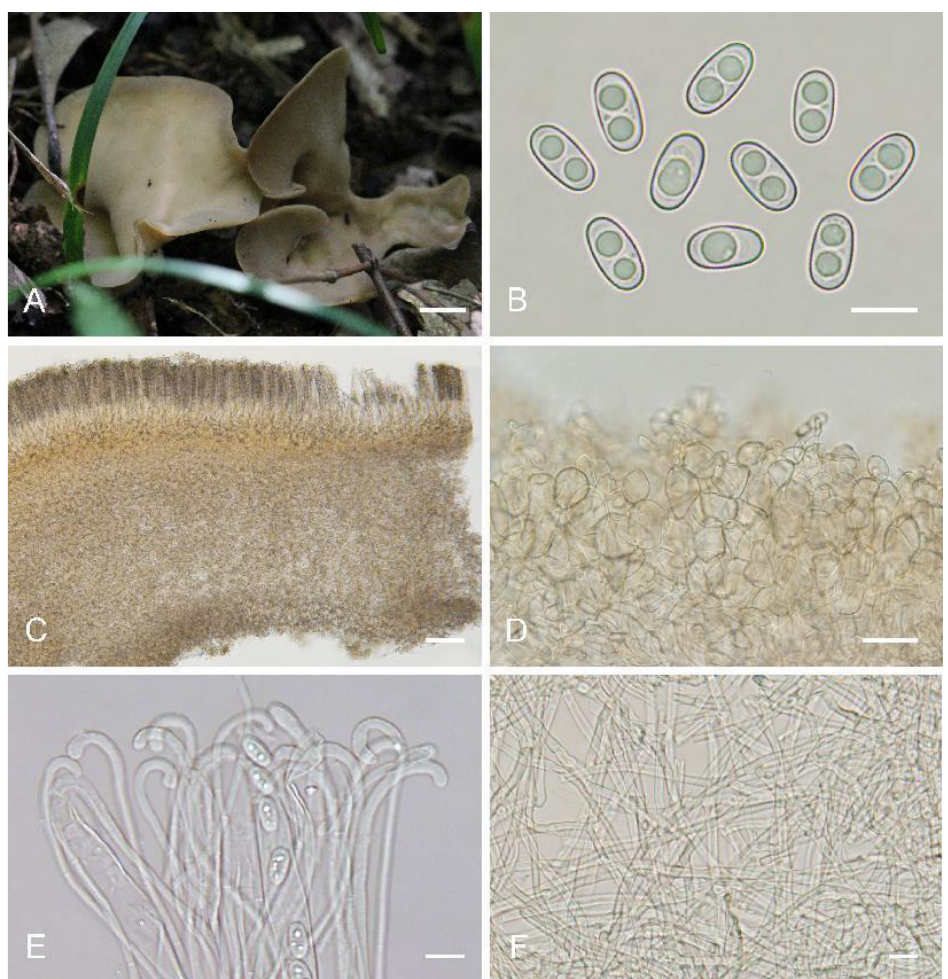
Figure 6. Otidea hanzhongensis (610723MF0034) ( A ) apothecia, ( B ) ascospores, ( C ) anatomy of apothecium, ( D ) ectal excipulum in water, ( E ) paraphyses, and ( F ) basal mycelium. Scale bars: ( A ) = 1 cm, ( B , E , F ) = 10 μm , ( C ) = 100 μm , ( D ) = 30 μm.